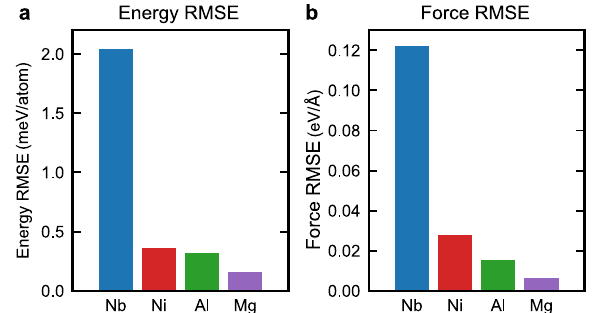
Fig. 2 Performance of the MTPs. The test set root-mean-square errors (RMSEs) of the high-MTPs (level 20) in ( a ) energy (per atom) and ( b ) forces in medium-size supercells.